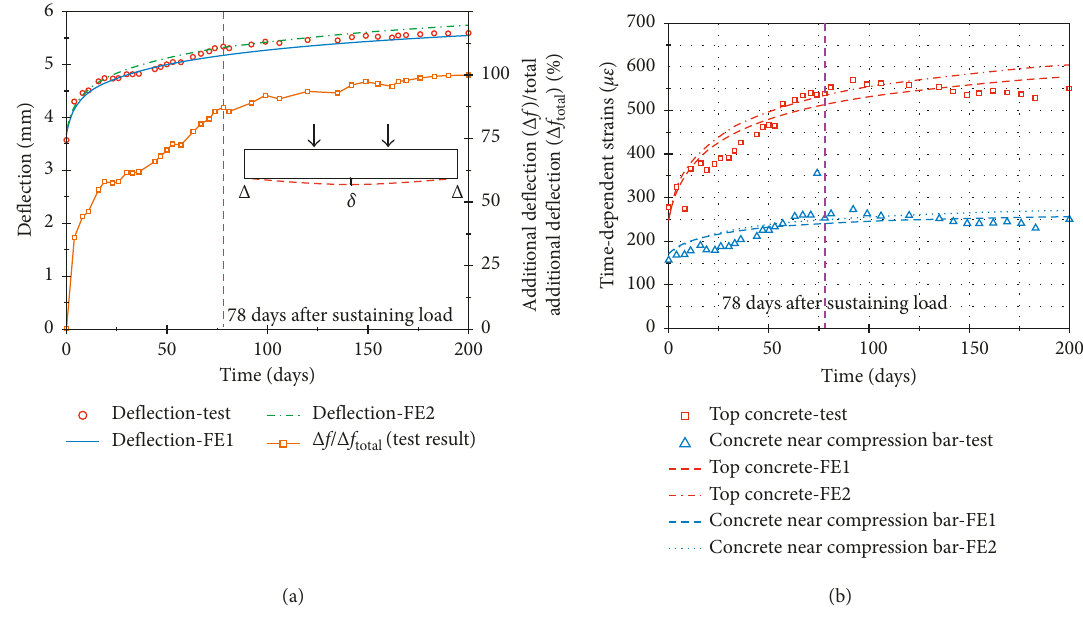
Figure 6: Test and FE results of the specimen. (a) Deflection at the midspan. (b) Concrete